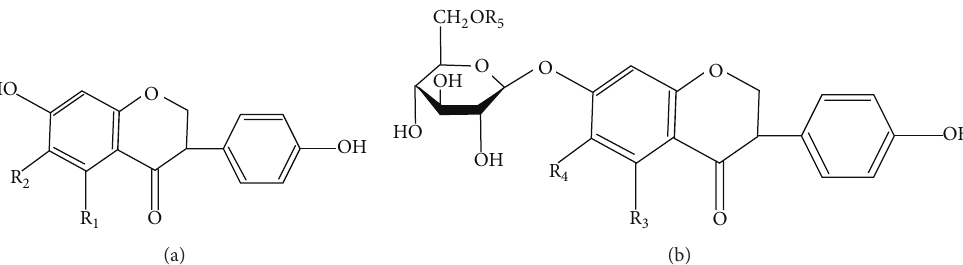
Figure 1: Chemical structures of isoflavones. (a) Unconjugated aglycones. (b) Respective glycoside conjugates. Each with different side chains attached to R1–R5